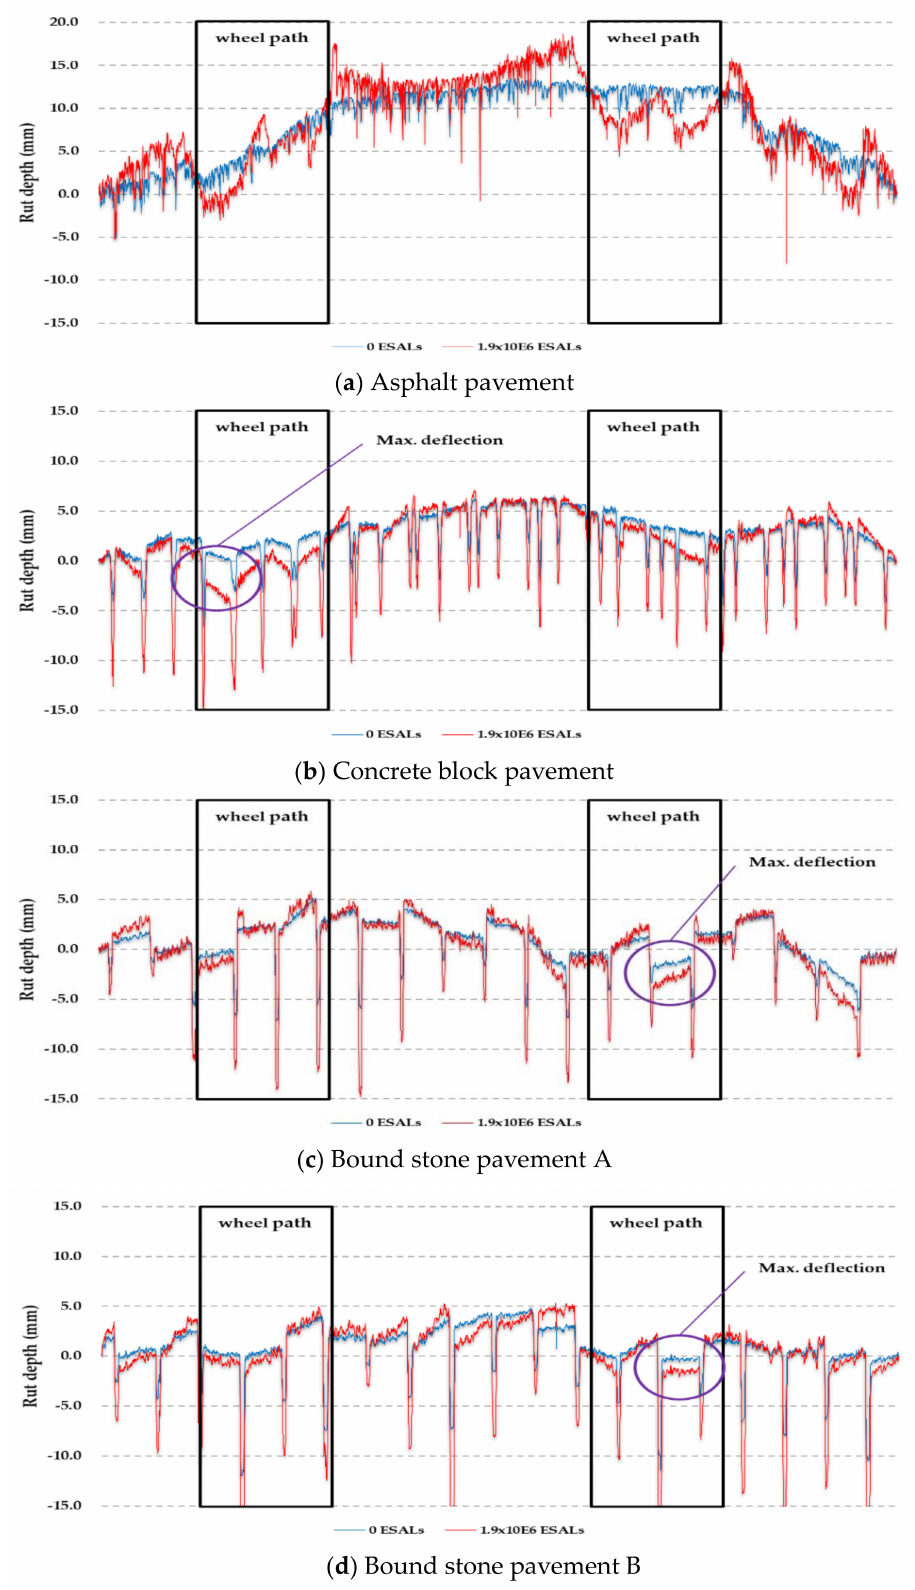
Figure 5. Transverse profiles of testing